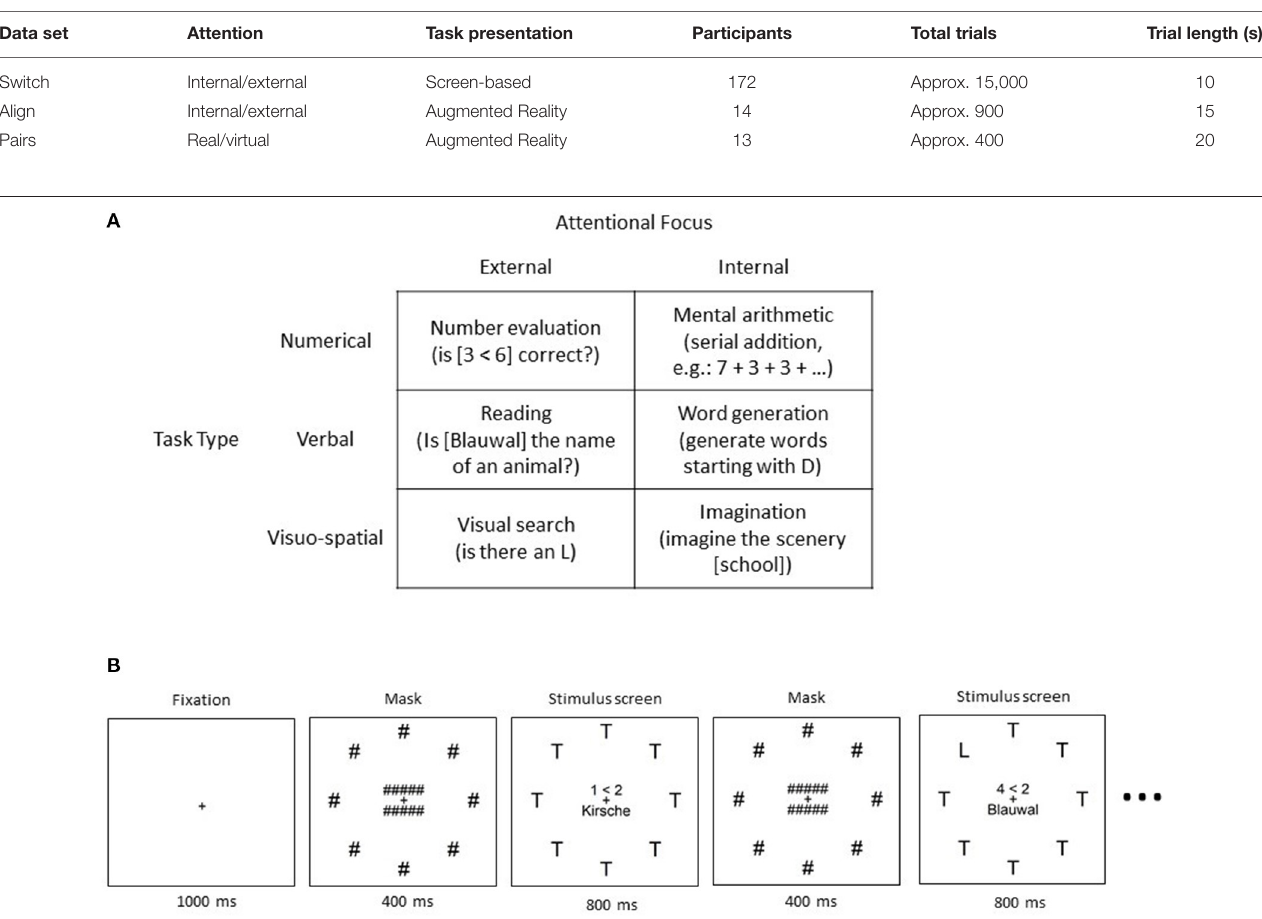
TABLE 1 | Overview of the three data sets including information about the tasks and scope.